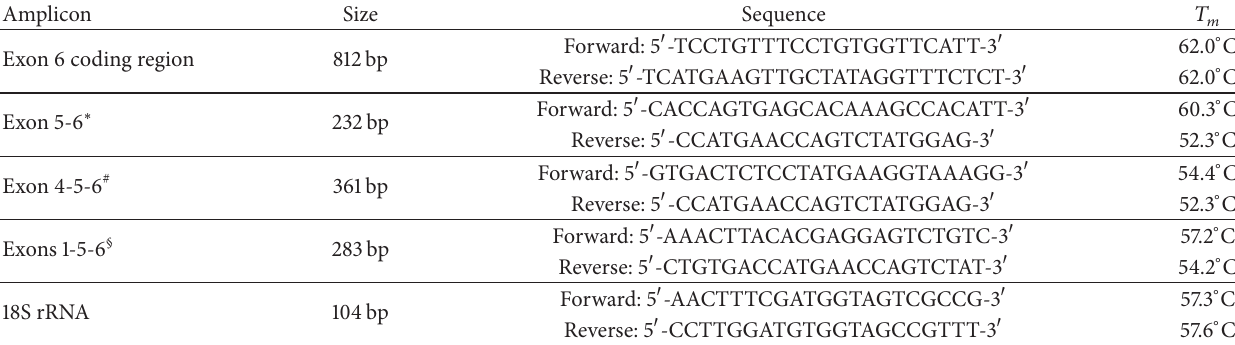
Table 2: Primer sequences used for conventional and quantitative PCR assays.